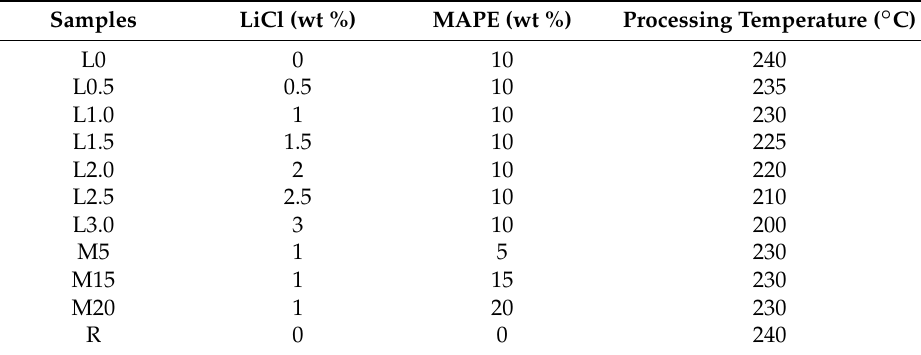
Table 1. Formulation and processing temperature of the